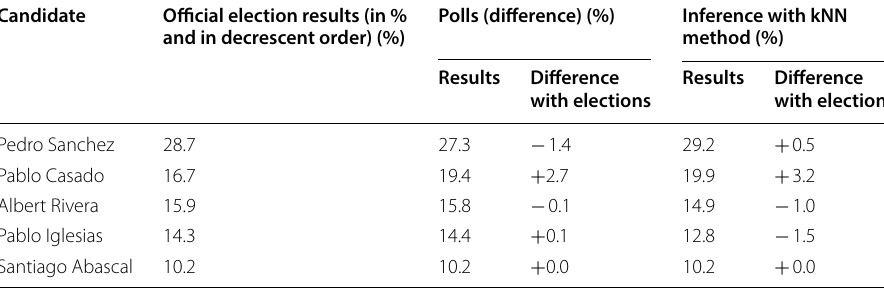
Table 3 Results and voting inference using kNN method